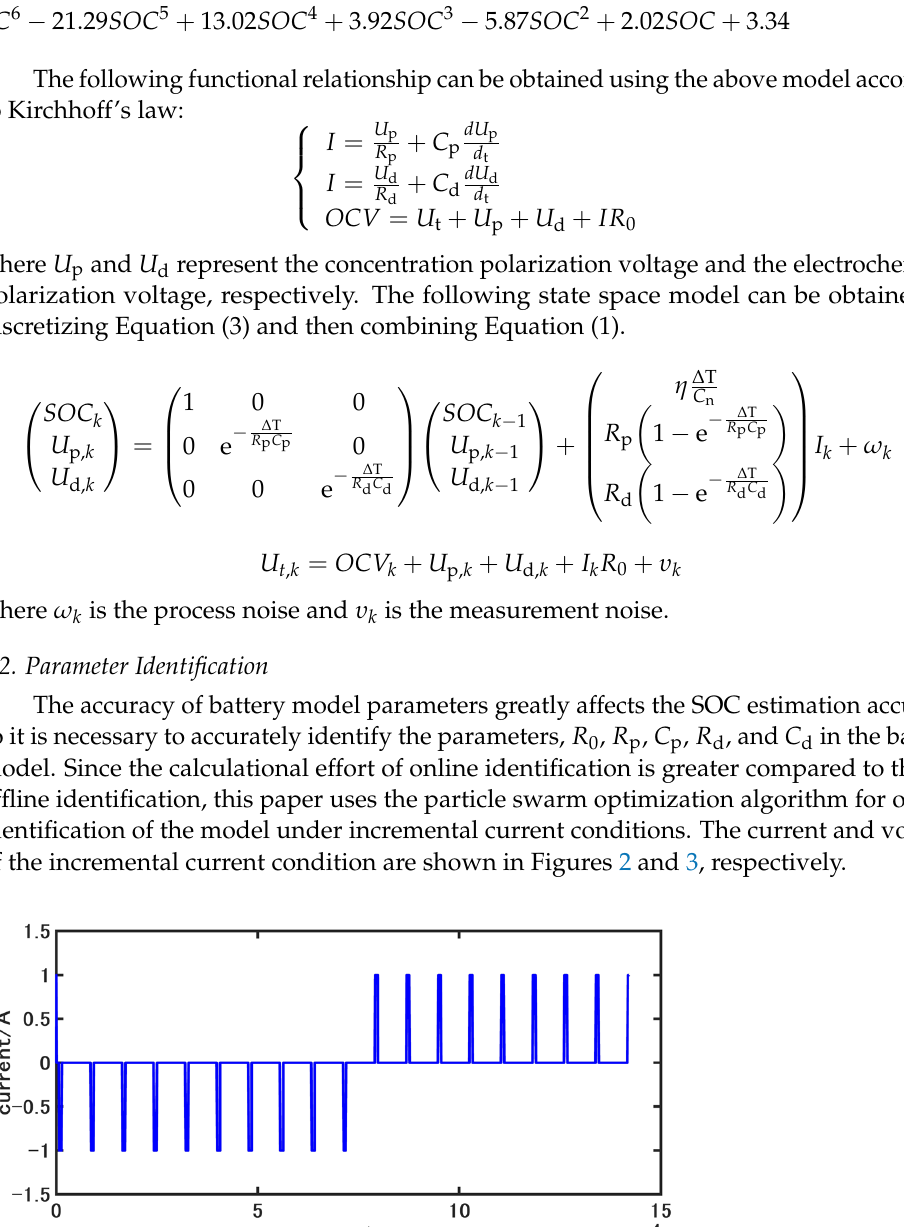
Figure 3. Voltage of Incremental Current Condition. The particle swarm optimization algorithm obtains the optimal solution by evaluat- ing the results of the fitness function and has a higher identification accuracy than the least squares algorithm [30]. The algorithm treats every feasible solution in the D-dimen- sional target search space as a particle, and each particle has its velocity and position. In parameter identification, that is, the set of five parameters is treated as a basic particle. During the iterative search process, the particle measures the quality of the current posi- tion based on its fitness and then updates it according to the global optimal position and the individual optimal position